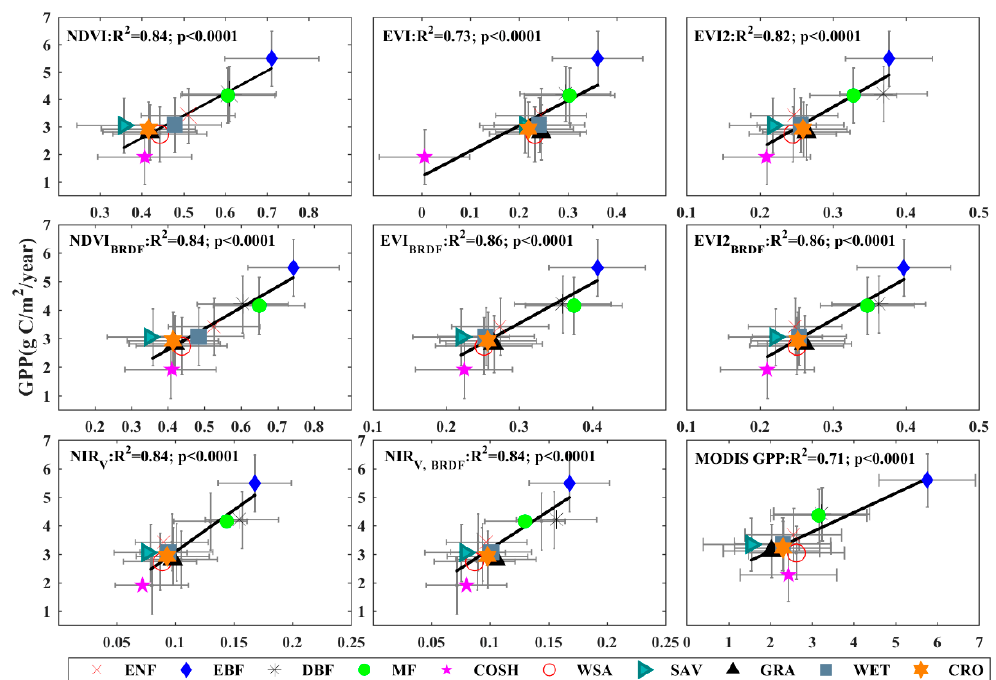
Figure 5. The relationships of VIs and MODIS GPP with tower GPP across ten biomes. The error bars are standard deviations across all sites within each biome. The biome types are as follows: evergreen needleleaf forest (ENF); evergreen broadleaf forest (EBF); deciduous needleleaf forest (DNF); mixed forest (MF); closed and open shrublands (COSH); woody savannas (WSA); savannas (SAV); grasslands (GRA); wetlands (WET); croplands (CRO).